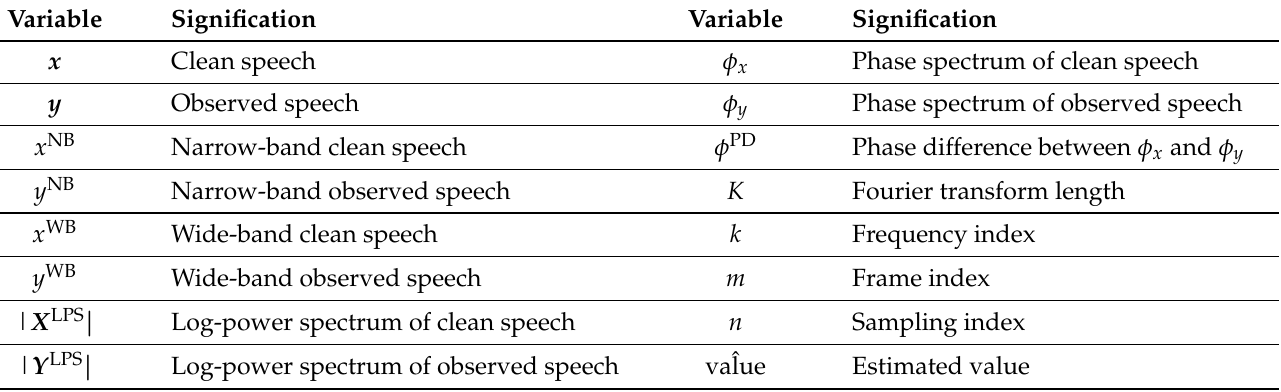
Table 1. List of notations.